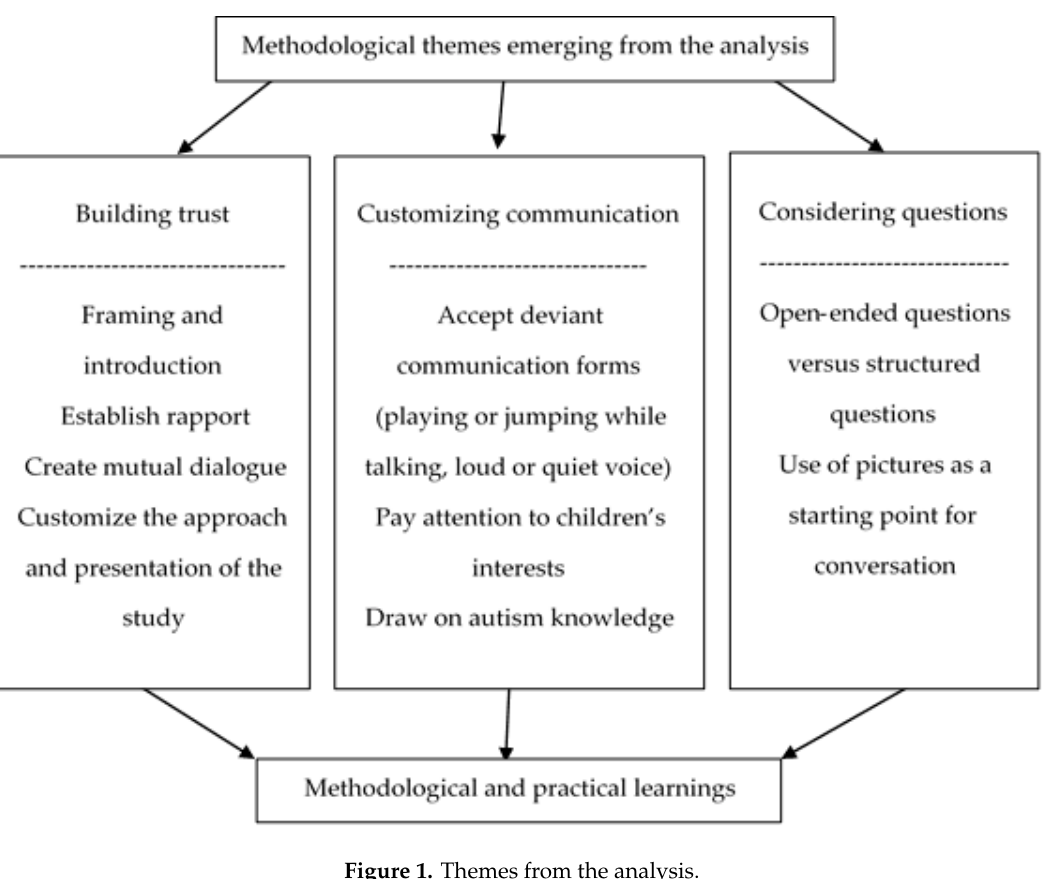
Figure 1. Themes from the analysis.